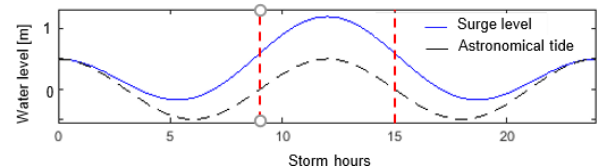
Figure 3. Qualitative example of the hydrograph of the storm wa- ter level: surge level (blue) and astronomical tide (black) over the length of a 24h storm. The red lines mark the modelled central 6h of the